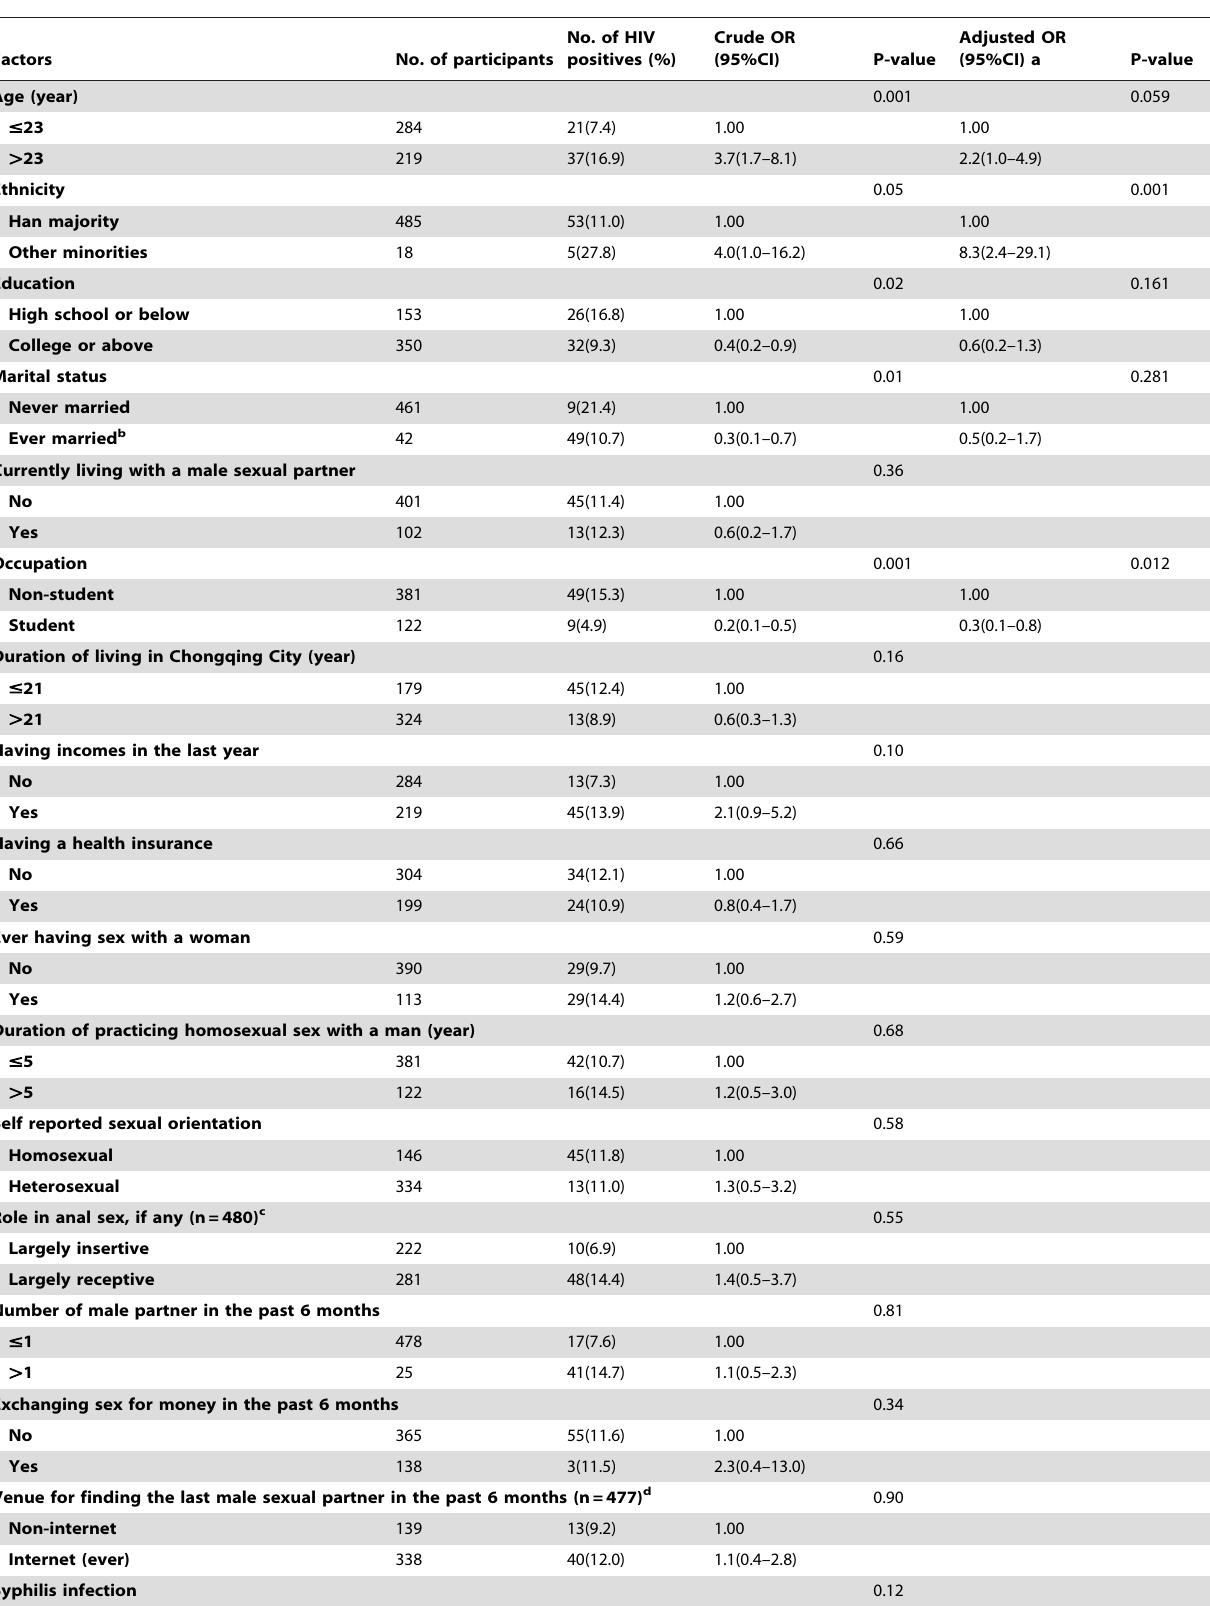
Table 2. Factors associated with HIV infection among 503 men who have sex with men in Chongqing City, China, 2009.